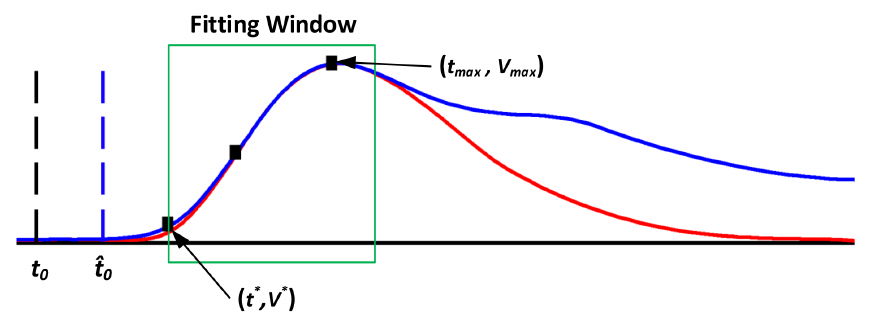
Figure 4. Ideal shape of envelope waveform. (Blue line: echo envelope; red line: curve-fitting result.)